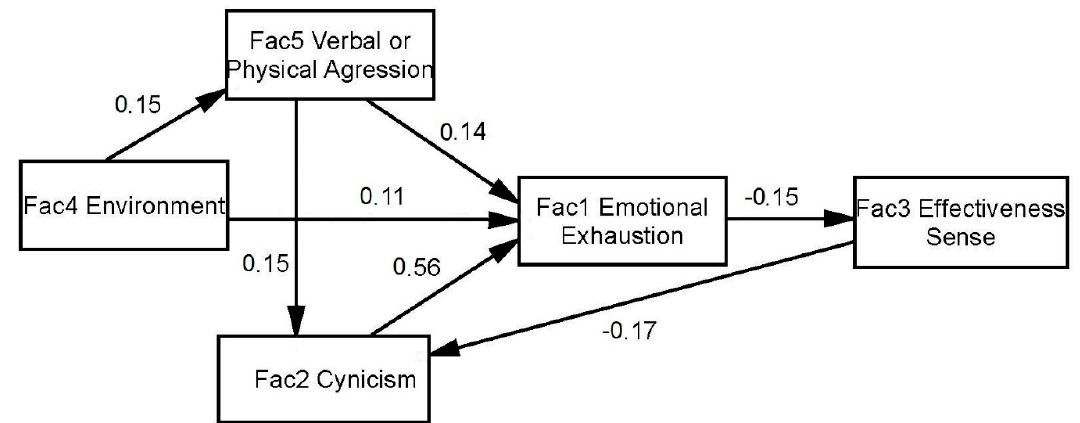
Figure 2. Path Model results. Relationships between the five factors under study converted into exogenous variables to reduce the complexity of the model. Abbreviations: Fac = factor.